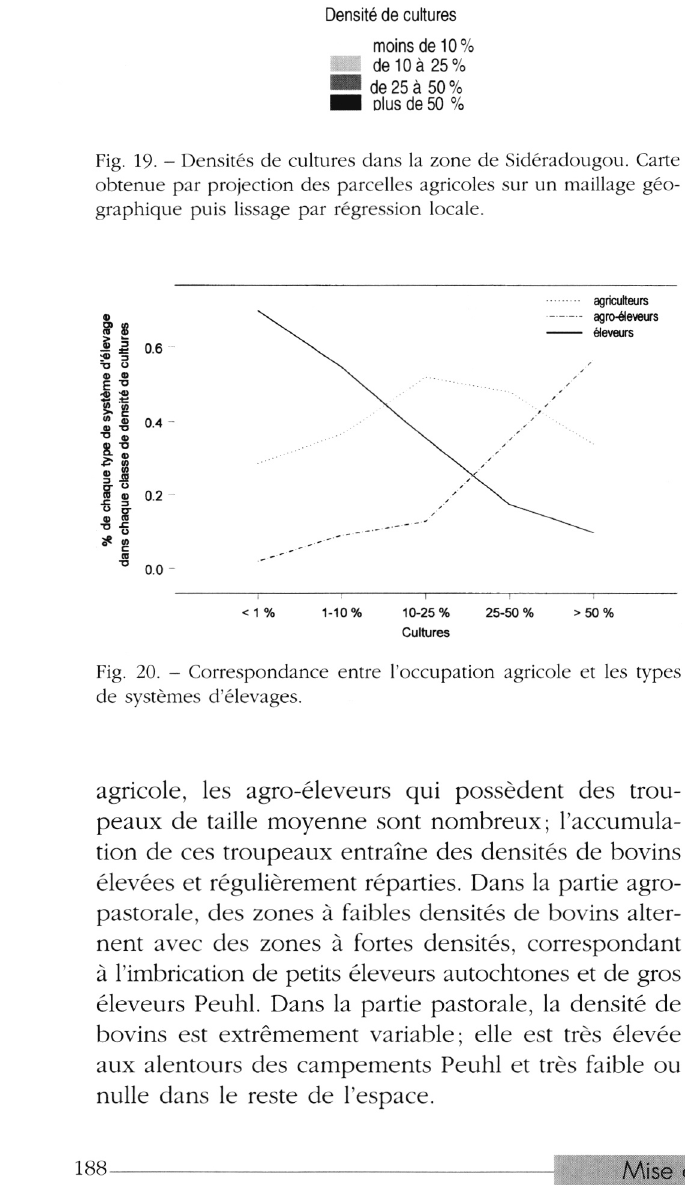
Fig. 21. - Correspondance entre les densités de bovins et l’occupa­ tion